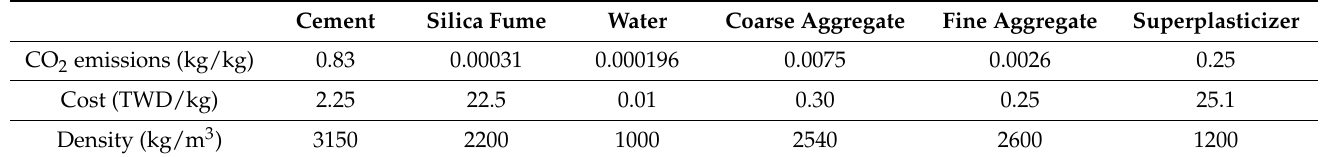
Table 1. CO 2 emissions, cost, and density of concrete components